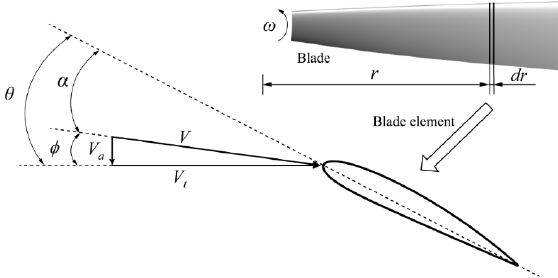
Figure 15. Flow environment at a typical blade element.